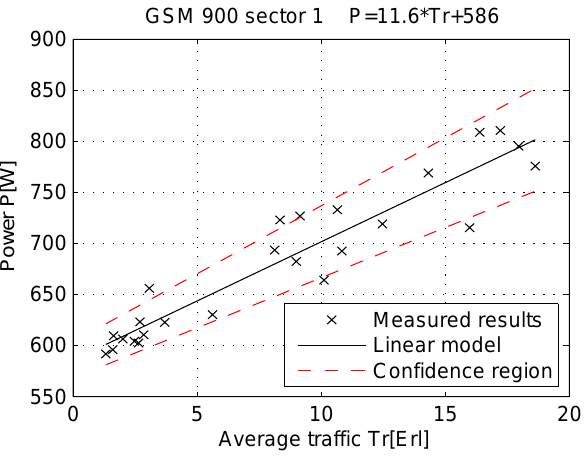
Figure 31. Power consumption model for GSM 900 sector 1 BS rack (Monday 18/07).